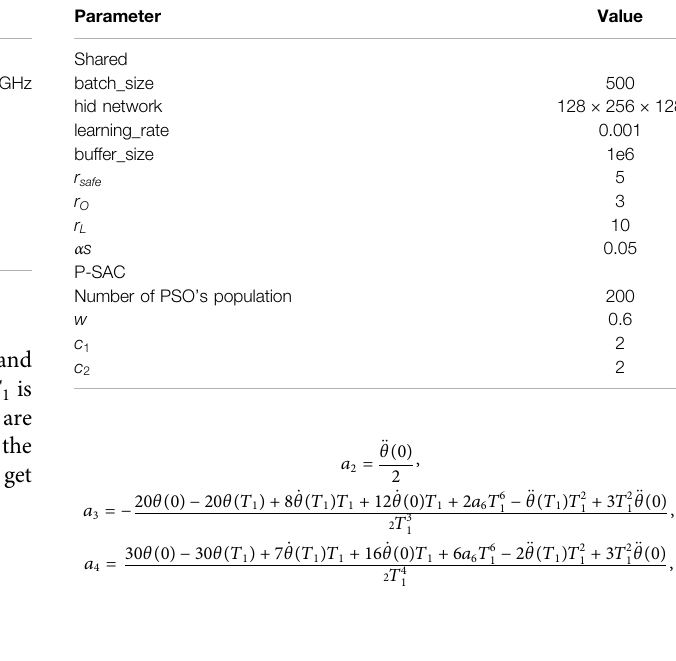
TABLE 3 | Environment of experimental software and hardware. TABLE 4 | Algorithm